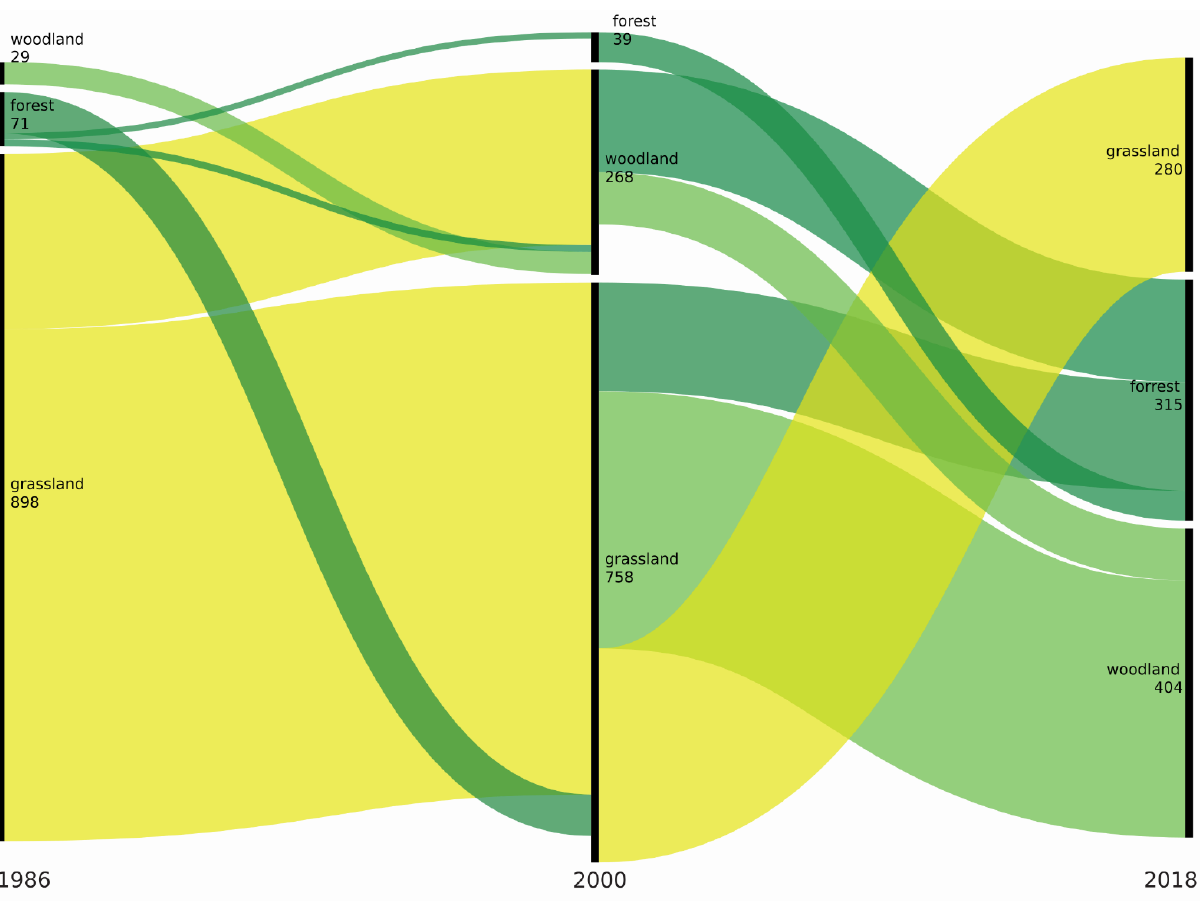
Figure 7. Land cover transitions within abandoned farmlands.